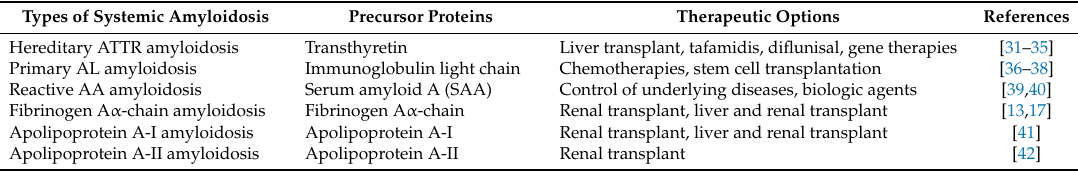
Table 2. Therapeutic options in major systemic